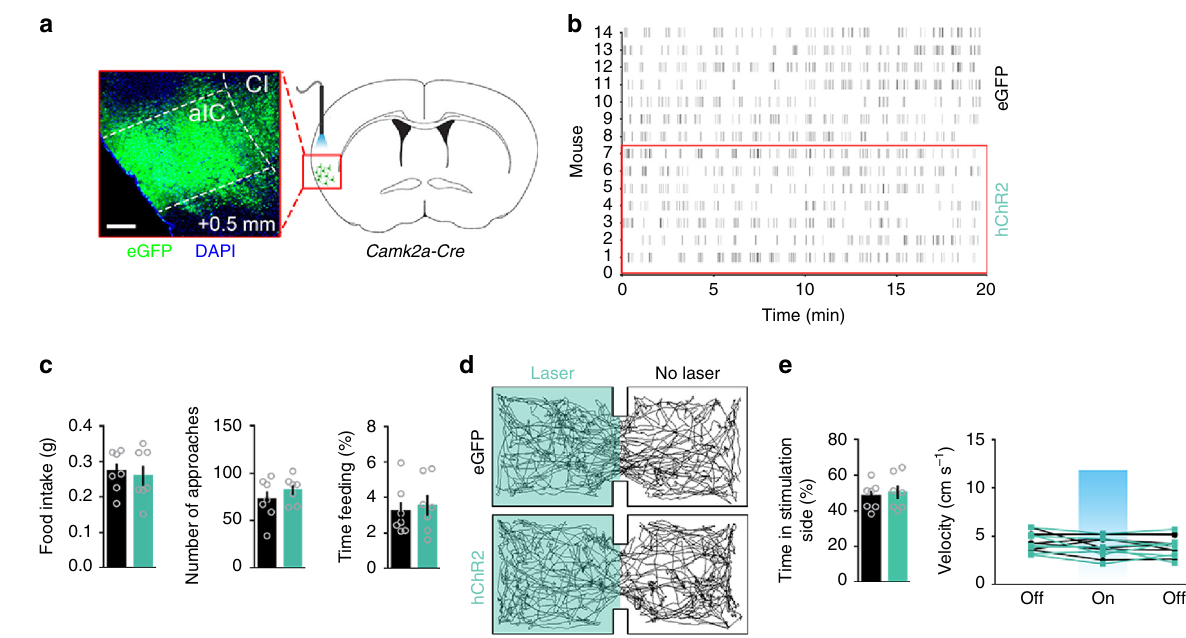
Fig. 4 Activation of the left aIC CamKII neuron has no effect on feeding behavior. a The inserted image shows the expression of hChR2-eGFP in the caudal segment of the left aIC. Scale bar, 250 μ m. b Raster plot of approaches to food in 24-h fasted mice expressing hChR2-eGFP in the caudal segment of the left aIC and receiving 20 Hz photostimulation. c Total food consumption (left), number of approaches (middle) and the percentage of feeding time (right) were measured ( n = 7 mice per group, Two-tailed unpaired t test). d Representative locomotor trace of a mouse with the caudal segment of the left aIC CamKII neurons expressing eGFP or hChR2 and receiving 20 Hz photostimulation in the laser compartment. e Percentage of time spent in the photostimulation side (left) and locomotor activity (right) in laser or no laser sides ( n = 7 mice per group, Two-tailed unpaired t test). Data are presented as means ± SEM. Source data are provided as a Source Data fi